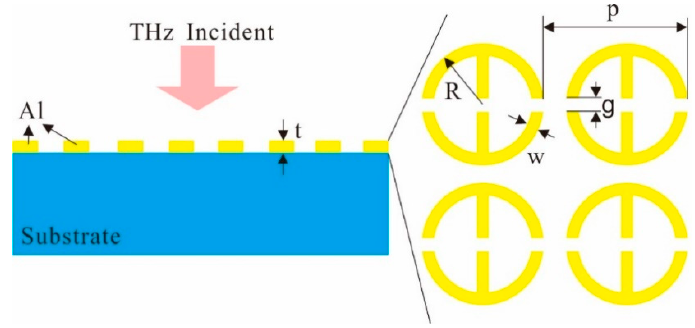
Figure 1. Sketch of the broadband Terahertz (THz) anisotropic metamaterial.